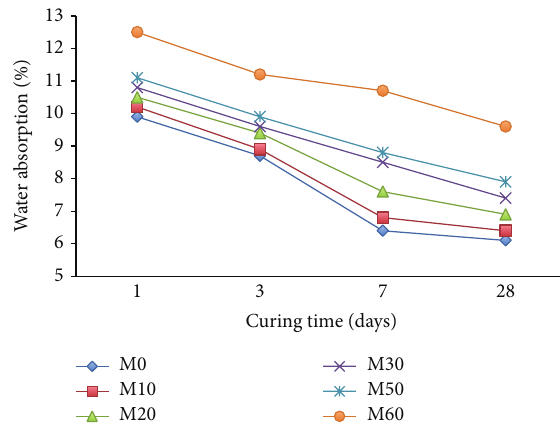
Figure 5: The effect of FA on water absorption of mortar mixes without